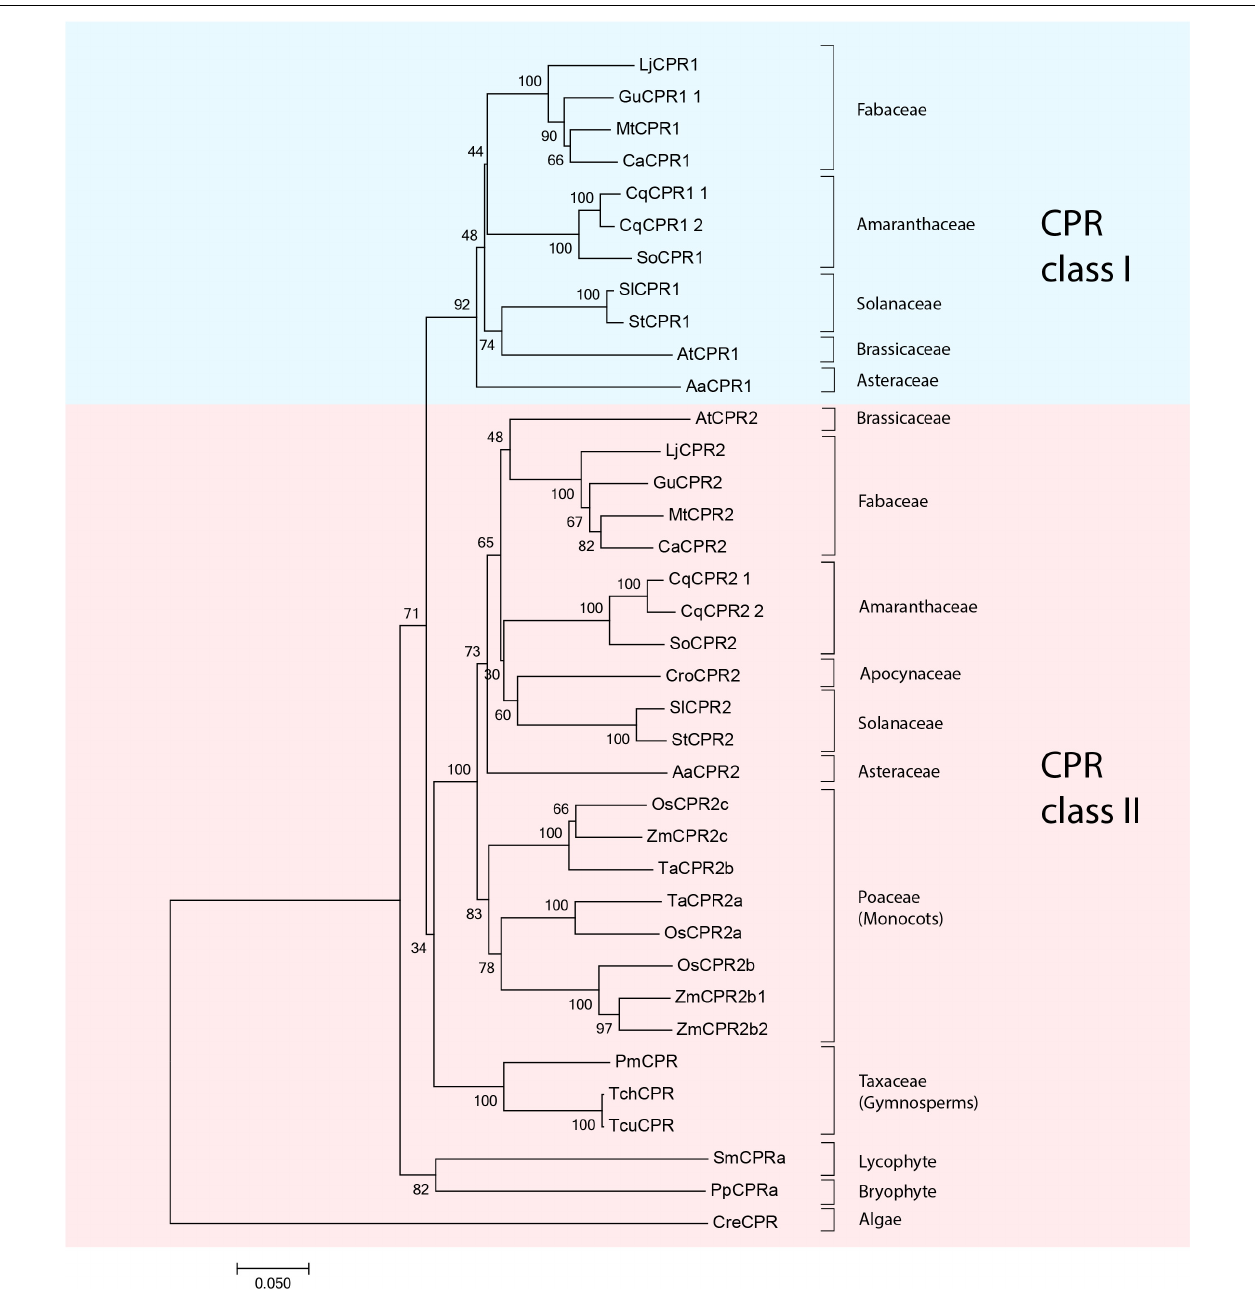
FIGURE 2 | Molecular phylogenetic tree of 42 CPR amino acid sequences from 19 different plant species shows clear branching of class I (blue shade) and II (pink shade) CPRs in higher plants. Sequences of CPR classes I and II from Medicago truncatula , Lotus japonicus , and Glycyrrhiza uralensis that were used for further analysis in this study are indicated as black dots. CPR, cytochrome P450 reductase; Aa, Artemisia annua ; ATR1, Arabidopsis thaliana CPR1 ; ATR2, Arabidopsis thaliana CPR2 ; Ca, Cicer arietinum ; Cre, Chlamydomonas reinhardtii ; Cro, Catharanthus roseus ; Cq, Chenopodium quinoa ; Gu, Glycyrrhiza uralensis ; Lj, Lotus japonicus ; Mt, Medicago truncatula ; Os, Oryza sativa ; Pm, Pseudotsuga menziesii ; Pp, Physcomitrella patens ; Sl, Solanum lycopersicum ; Sm, Selaginella moellendorffii ; St, Solanum tuberosum ; Ta, Triticum aestivum ; Tch, Taxus chinensis ; Tcu, Taxus cuspidata ; Zm, Zea mays.